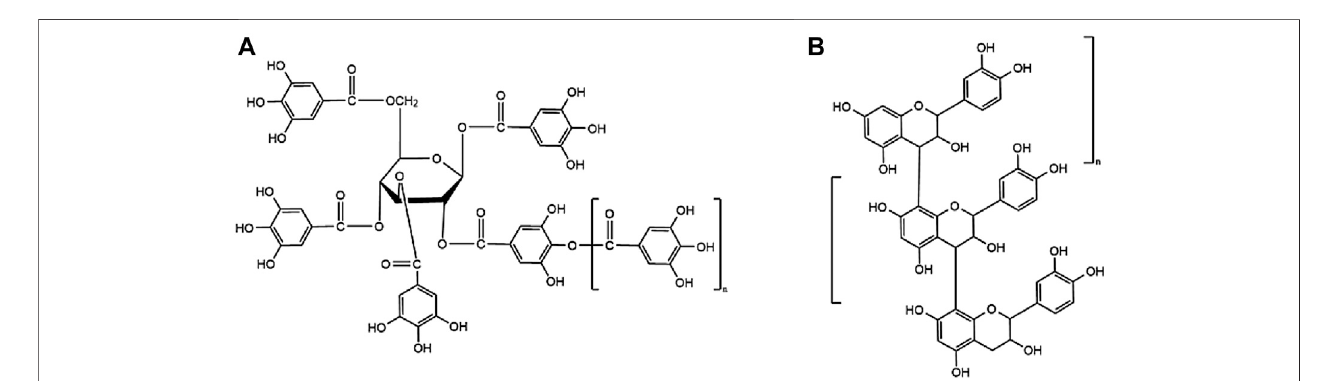
FIGURE 2 | Structural representation of typical hydrolyzed tannins (A) and condensed tannins (B) .